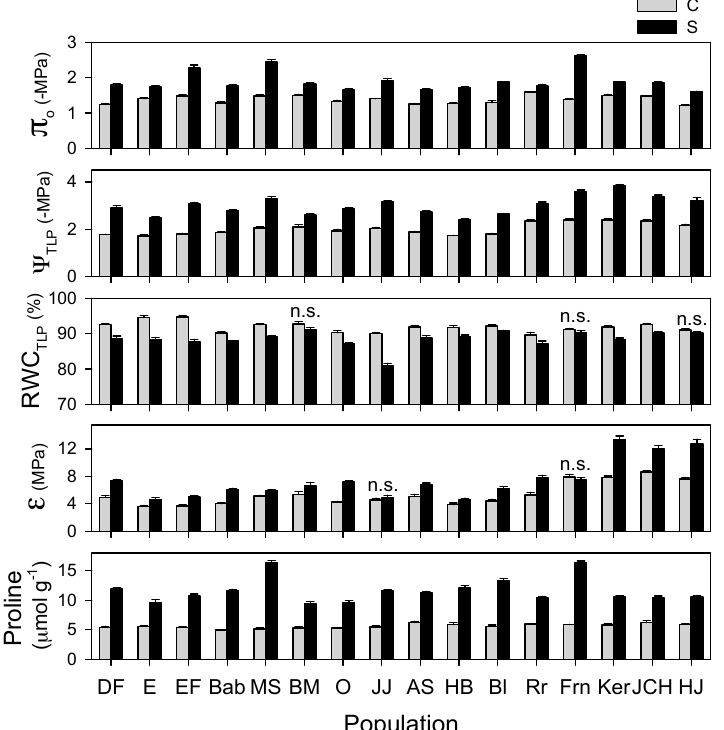
Figure 5. Parameters derived from the pressure–volume relationships and proline concentration for control (C) and water stressed (S) seedlings of the 16 Quercus suber populations. Data are mean + SE. Population codes are as in Table 1. In most cases, significant differences between C and S were found (Tukey’s test, p < 0.05). Those populations with n.s. above a trait mean that there were no significant differences between C and S. π o , osmotic potential at full turgor; Ψ TLP , water potential at turgor loss point; RWC TLP , relative water content at turgor loss point; ε , bulk modulus of elasticity.